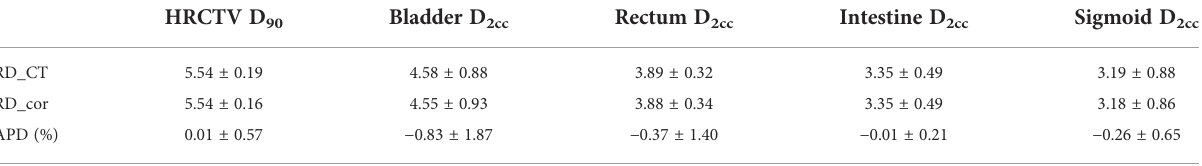
TABLE 7 Dosimetric comparison of HRCTV and OARs between RD_CT and RD_cor plans (unit: Gy; (cid:1) x ± s